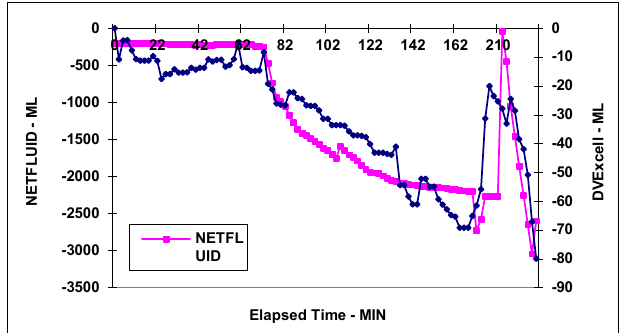
Fig.2: Changes in NETFLUID and abdominal DVExcell vs elapsed time